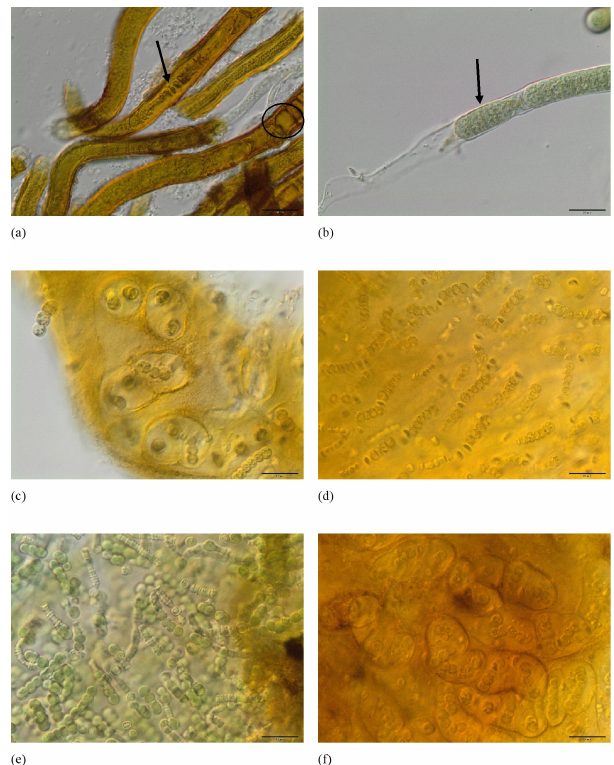
Figure 4. Micrographs of cyanobacterial growth and reproduction, scale bars 20µm: (a) Scytonema sp. with desiccated cells and fila- ments encased in outer sheath containing a high level of pigmenta- tion (arrows), heterocytes (circled) and heavy cyanophycin granula- tion; (b) Scytonema sp. new growth filaments illustrating hormogo- nia release (arrow); (c, d) new colonies of Nostoc sp. illustrating extracellular polysaccharide (EPS) capsules and surrounding EPS that delivers a microenvironment for other cyanobacteria species cohabitation; (e) mature colonies of Nostoc sp. with heterocytes; (f) example of distinct EPS encapsulating Nostoc filaments within the overall colonial structure also bound together by EPS.